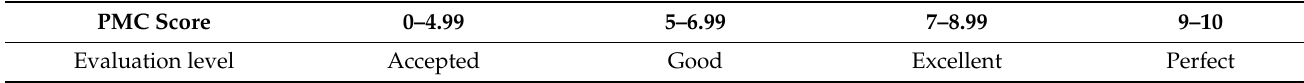
Table 7. PMC Index Policy Grading.